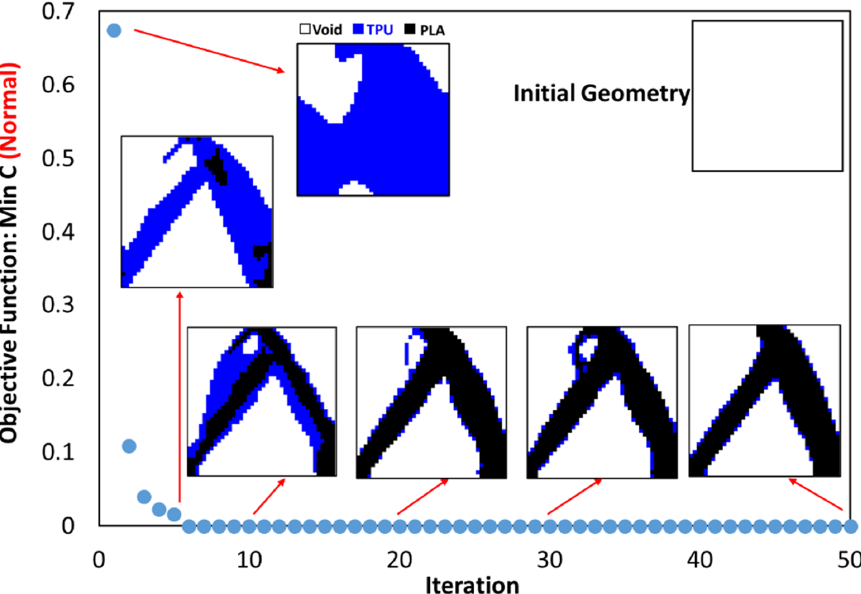
Figure 8. The convergence diagram of the objective function for optimal material distribution.